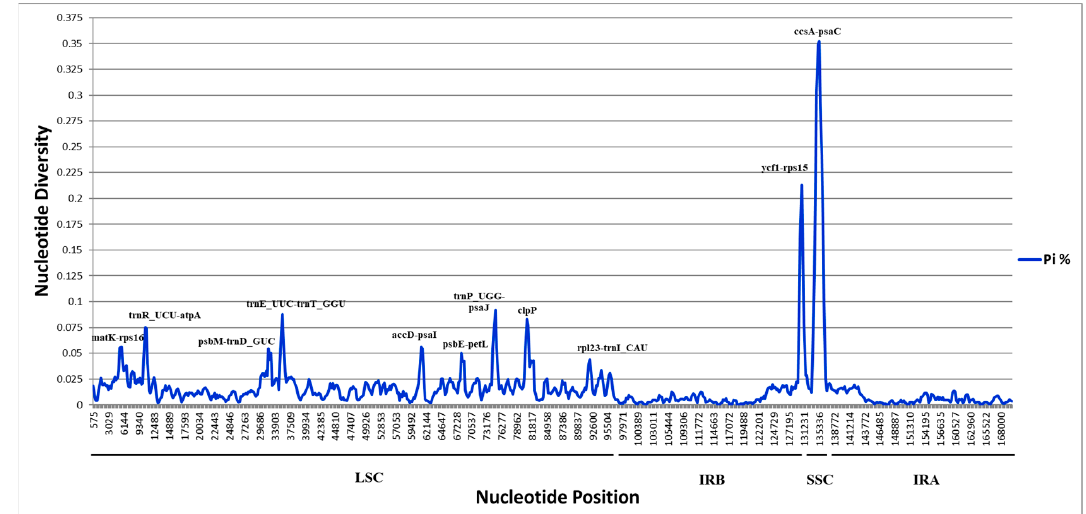
Figure 4. Sliding window of nucleotide diversity from the alignment of four Paphiopedilum plastomes. (Pi %) Parsimony rate; (IR) inverted repeat regions; (LSC) large single-copy region; (SSC) small single-copy region; red line: diversity threshold.